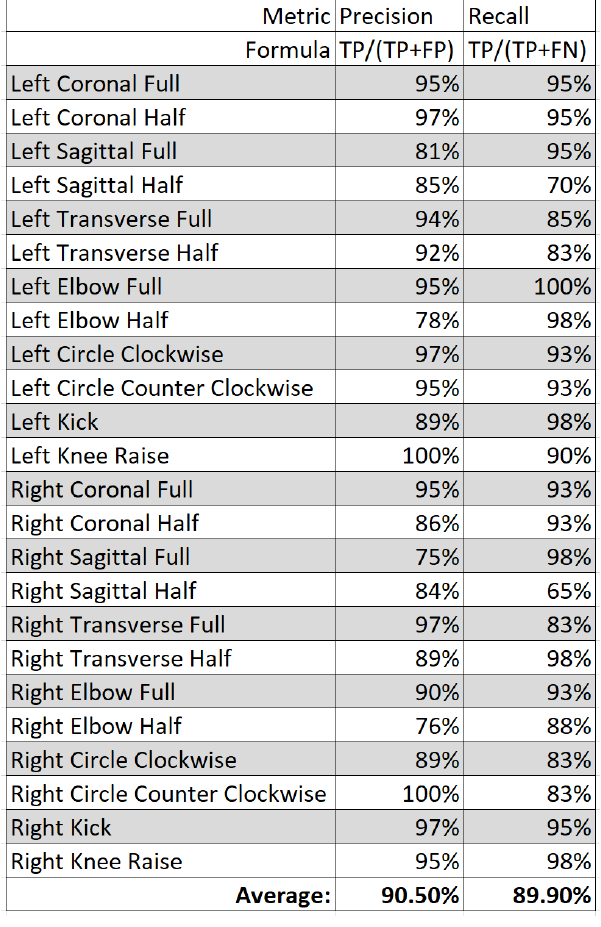
Table 2. Precision and Recall of the